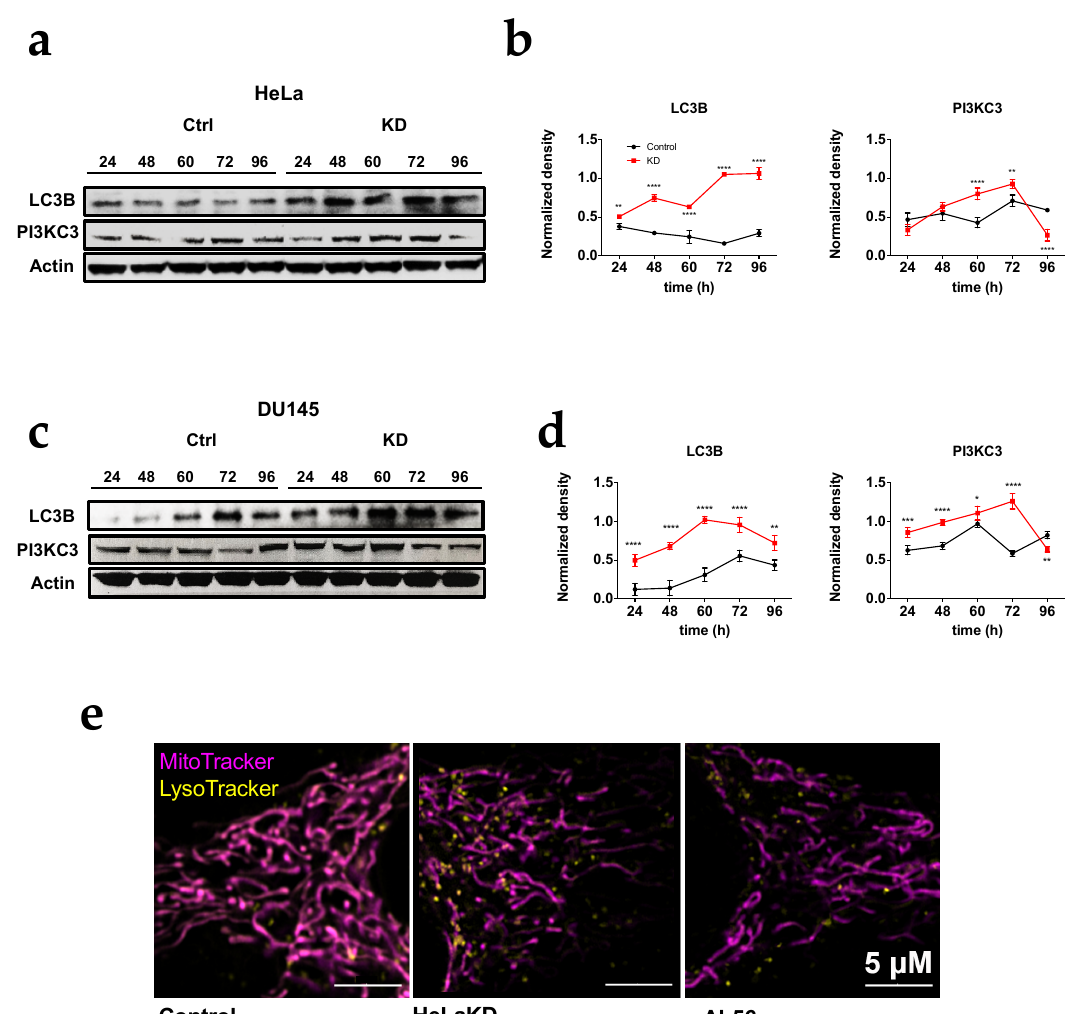
Figure 5. HeLa KD and DU145KD cells show an increase in autophagic components. ( a ) Representative blots of proteins involved in autophagy in HeLa and HeLa KD cells. Actin was used as a loading control in all cases. ( b ) Densitometric analysis of the autophagic protein content HeLa and HeLa KD cells the values were normalized to actin. ( c ) Representative Western blots in DU145 and DU145KD cells. ( d ) Densitometric analysis of the autophagic protein content DU145 and DU145KD cells the values were normalized to actin. ( e ) Cells treated with control siRNA (left), Kv10.1 siRNA (center) or mAb56 (right) were incubated with Mitotacker (mitochondria, magenta) and Lysotracker (lysosomes, yellow) and analyzed in live cells by confocal microscopy (Airy super resolution). Note the increase in LysoTracker signal in KD and mAb56 treated cells. values in ( b , d ) are mean ± SEM of three independent experiments (* p < 0.05. ** p < 0.01. **** p < 0.001, **** p < 0.0001, 2-way